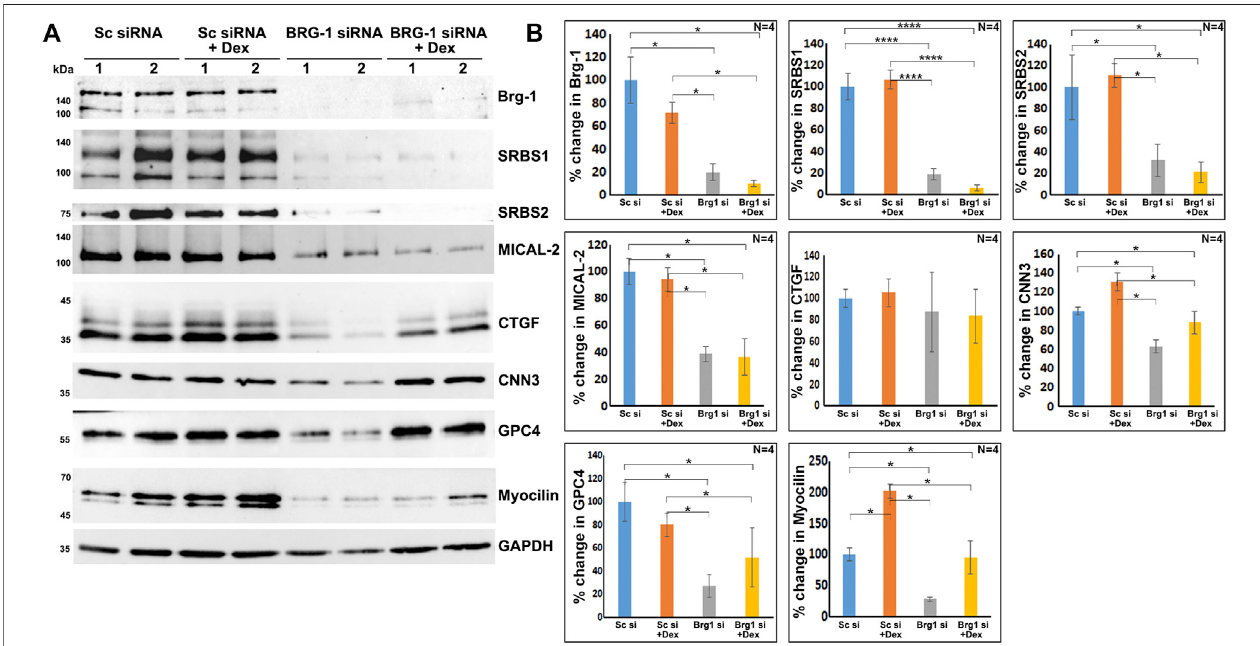
FIGURE 8 | BRG1 de fi ciency decreases the levels of various proteins in TM cells under both basal and Dex stimulated conditions. (A,B) BRG1 siRNA and a corresponding scrambled siRNA control were used to determine the role of the chromatin remodeling protein BRG1 in the expression of the indicated proteins in TM cells. Cells were initially treated with siRNA for 24 h prior to the addition of Dex or vehicle and continuation of incubation for another 48 h. Cell lysates were prepared for immunoblotting based quanti fi cation of the proteins of interest. As shown in the fi gure, treatment with BRG1 siRNA signi fi cantly reduced the levels of BRG1 and